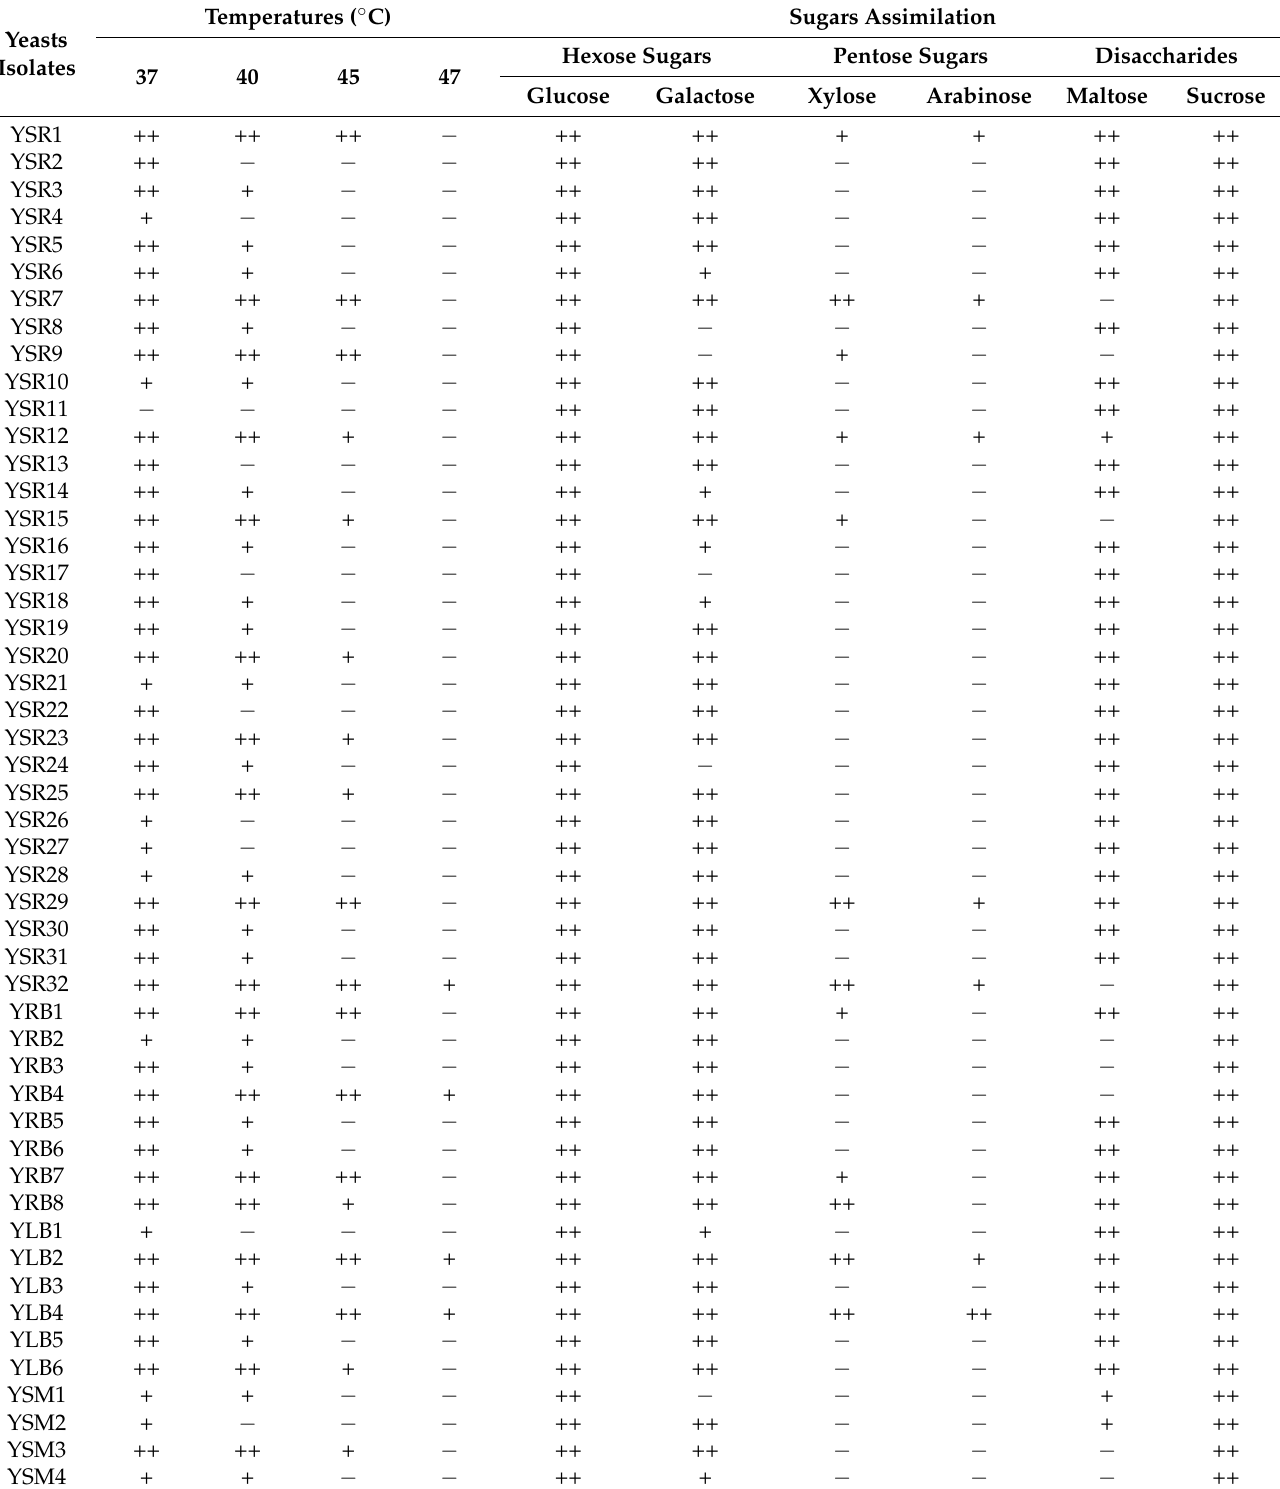
Table 1. Temperature and sugar assimilation profiles of the isolated